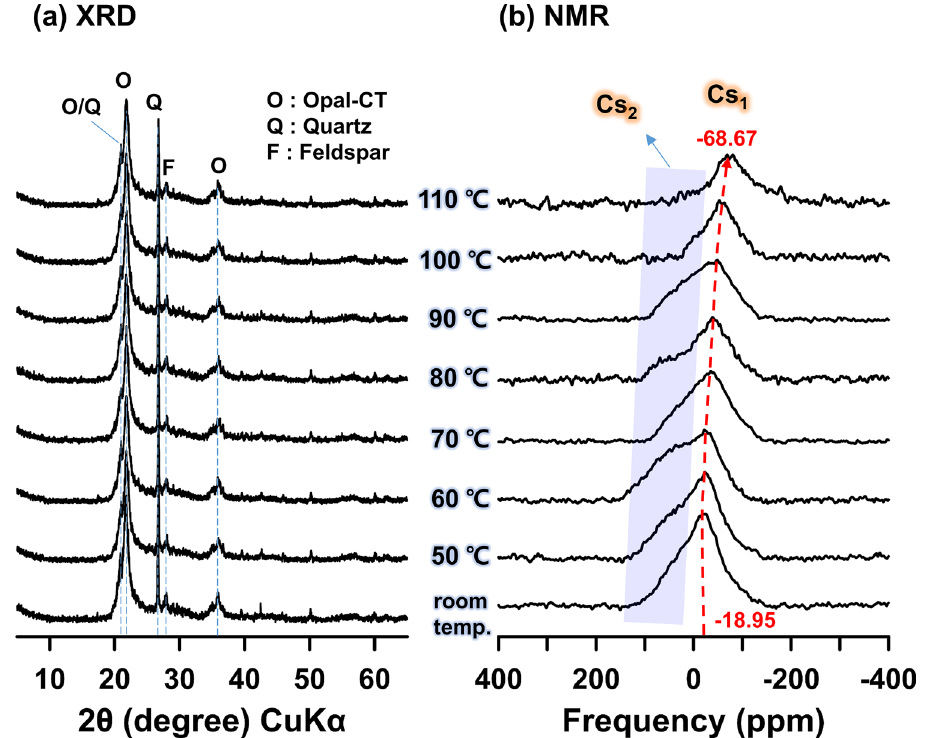
Figure 7. The ( a ) XRD, and ( b ) 133 Cs MAS NMR spectra of base-activated opaline mudstone, after Cs adsorption at temperatures from RT to 110 °C.